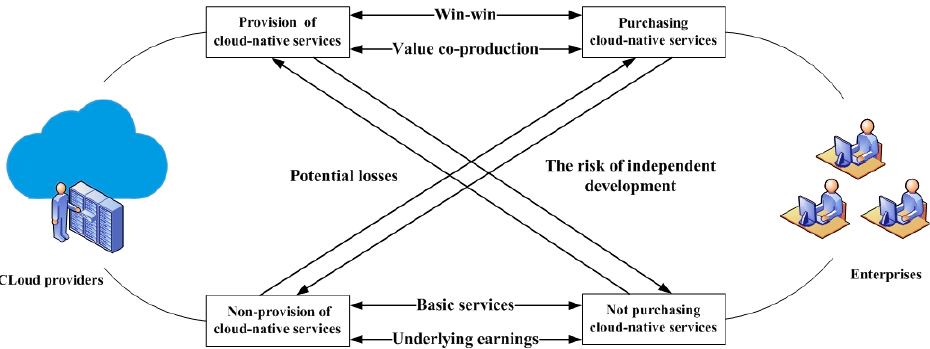
Figure 2. The game relationship between cloud providers and enterprises.